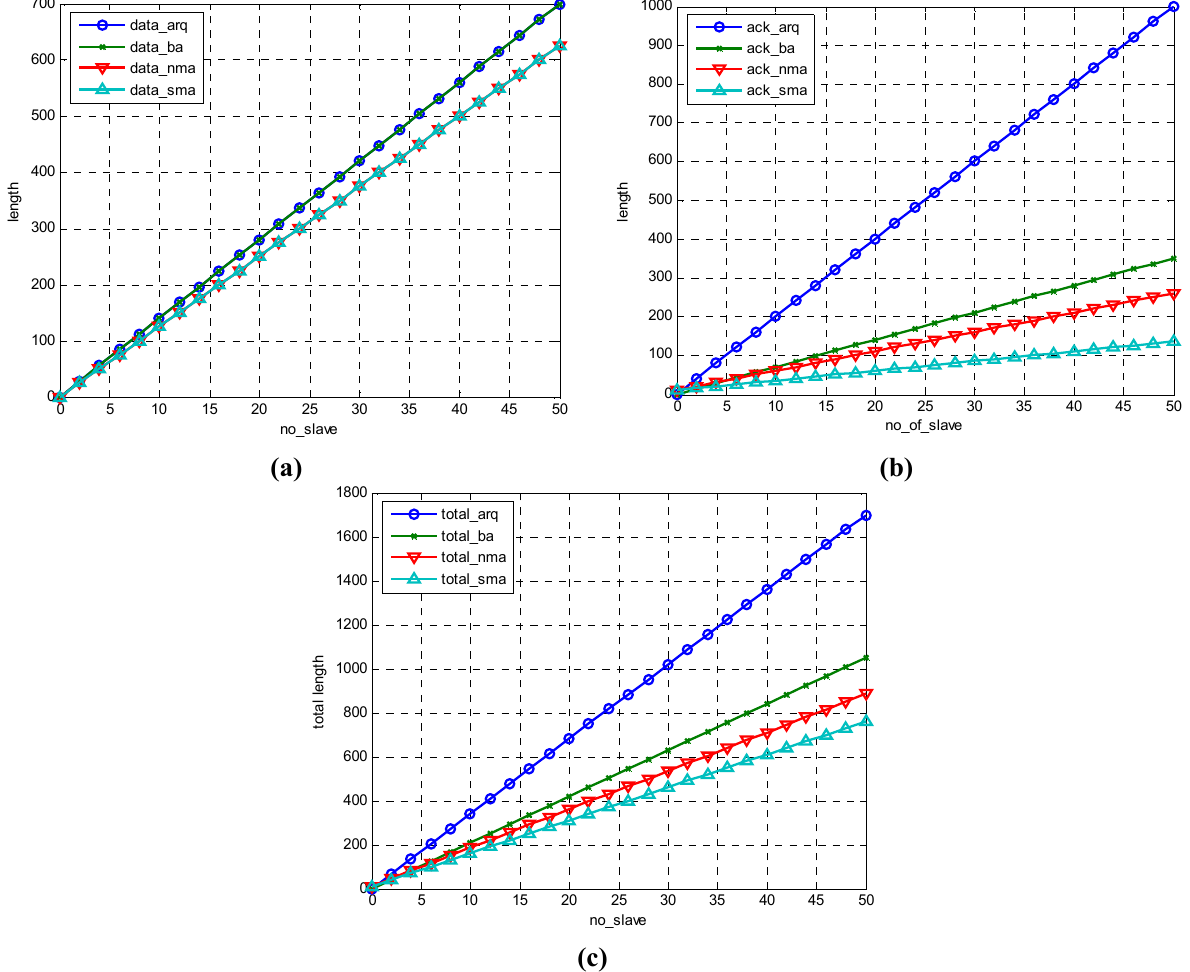
Figure 11. Frame Length (a) data length (b) ack length (c) total